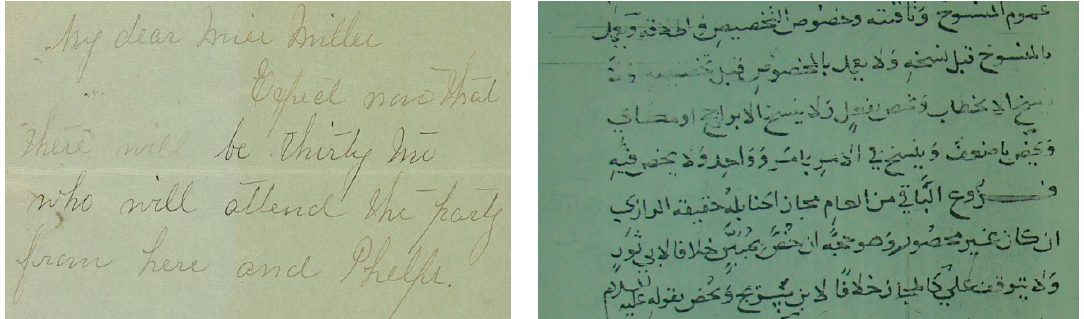
Figure 6. Example of DIBCO (left) and Arabic (right) database images showing faded degradation.